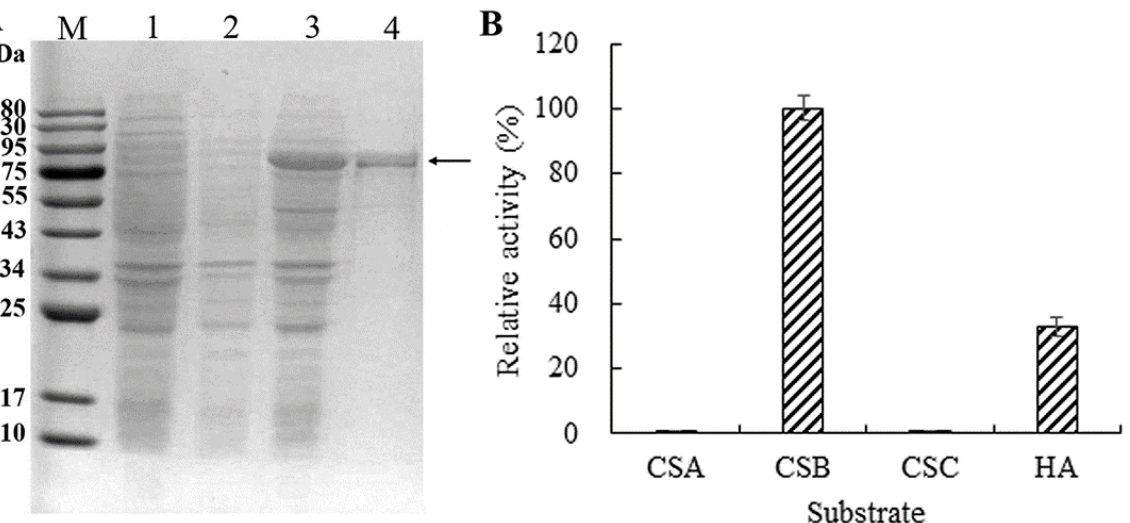
Figure 2. Expression and substrate specificity of recombinant ChSase B6. ( A ) Expression of the re- combinant ChSase B6 in E. coli. Lane M: protein molecular weight marker; Lane 1: induced E. coli containing pET-28a(+); Lane 2: non-induced E. coli containing pET-28a- ChSase ; Lane 3: induced E. coli containing pET-28a- ChSase ; Lane 4: purified recombinant ChSase B6 protein; ( B ) Substrate spec- ificity of recombinant ChSase B6. The substrates tested include chondroitin sulfate A (CSA), chon- droitin sulfate B (CSB), chondroitin sulfate C (CSC), and hyaluronic acid (HA). Table 1. Tryptic peptide sequencing of fractionated ChSase B6 by Nano-ESI-MS/MS. Sequence